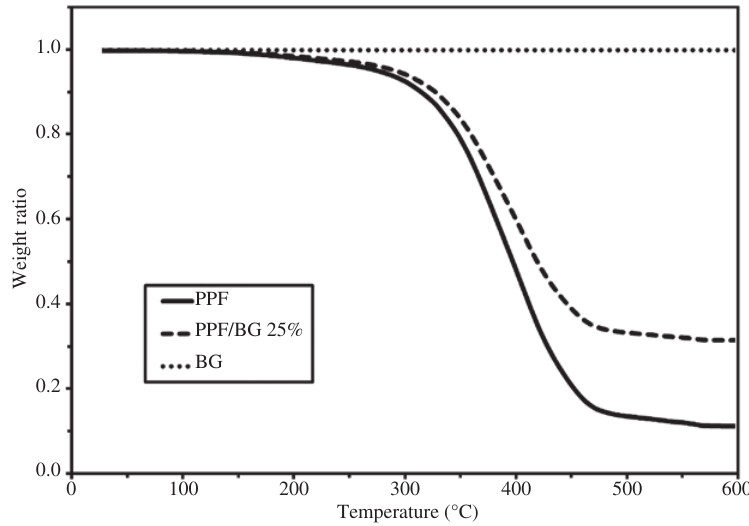
Figure 2 TGA of PPF microspheres and PPF/BG